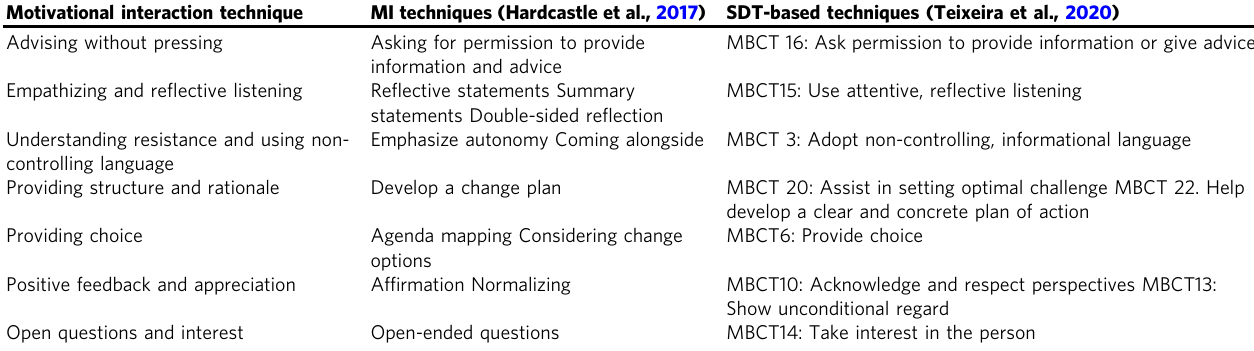
Table 1 Techniques of motivational interaction mapped onto MI and SDT technique